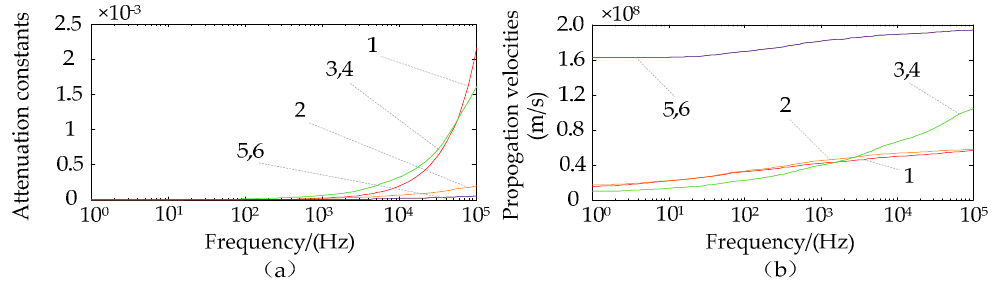
Figure 3. Attenuation constants and propagation velocities of each mode currents. ( a ) Attenuation constants. ( b ) Propagation velocities.